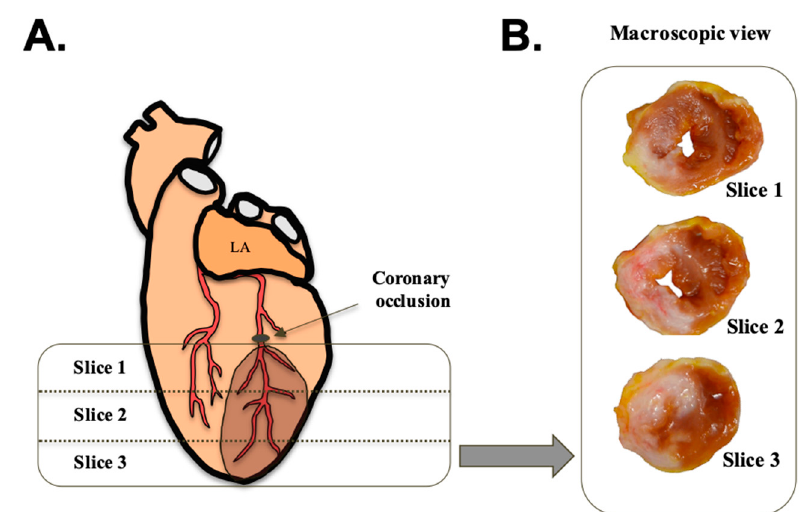
Figure 4. ( A ): A schematic representation of the sections of the heart (slice 1, 2, and 3), located below the coronary ligature. The dark area corresponds to the infarcted area. ( B ): An example of the three sections with thioflavin-S staining without ultraviolet light for macroscopic observation. The necrotic tissue is depicted in each section. Abbreviations: LA: left atrium.